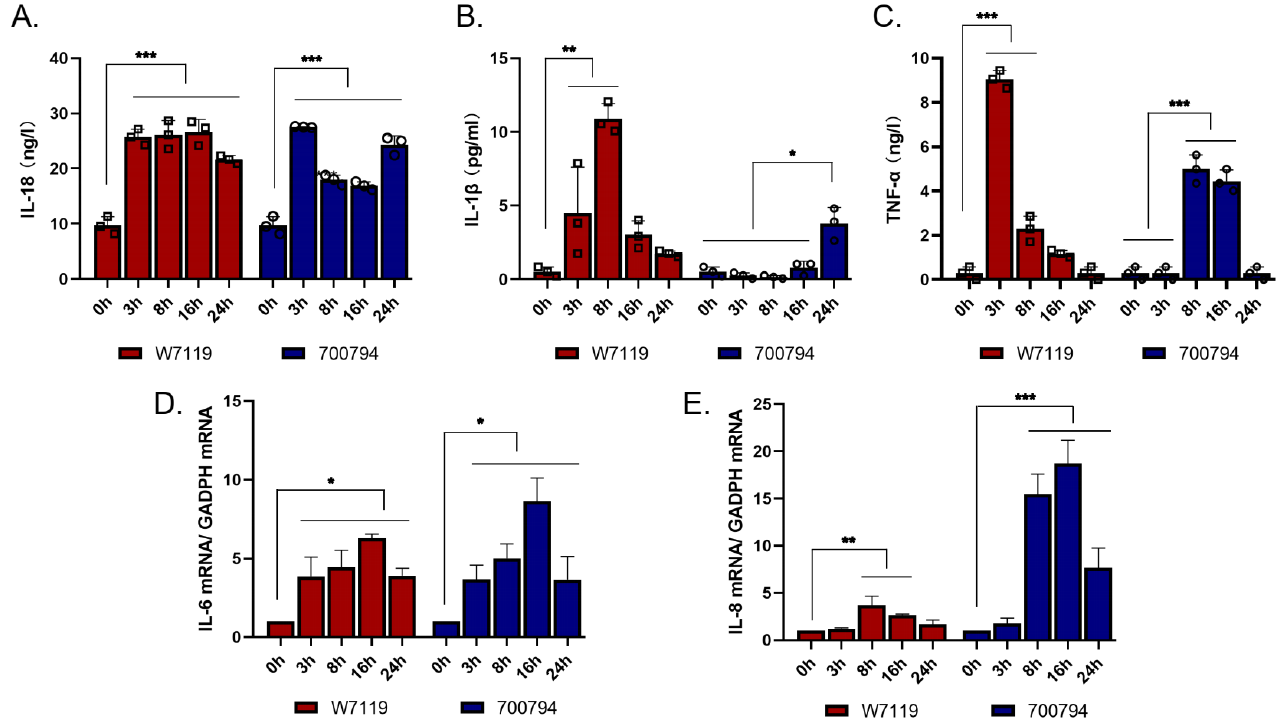
Figure 4. S. suis induces expression of inflammatory mediators in PAM-Tang cells. PAM-Tang cells were infected with S. suis vir-700794 or S. suis avir-W7119 at MOI = 1 for 3, 8, 16, or 24 h, negative control expressed as 0 h. After infection, ELISA kits were used to detect culture supernatants levels of IL-18 ( A ), IL-1 β ( B ), and TNF- α ( C ). The squares represent S. suis W7119 infection group ( n = 3), circles represent S. suis 700794 infection group ( n = 3). Quantitative RT-PCR assay was used to detect transcriptome levels of IL-6 ( D ) and IL-8 ( E ) in cells after infection. All treatments were carried out in three wells, and experiments were repeated three times. The data used for statistical analysis represent the mean ± SD of cytokines secreted into the cell supernatant at each time point, significance was determined using two-way ANOVA and Tukey’s multiple-comparison test; *: p < 0.05; **: p < 0.01; ***: p < 0.001.